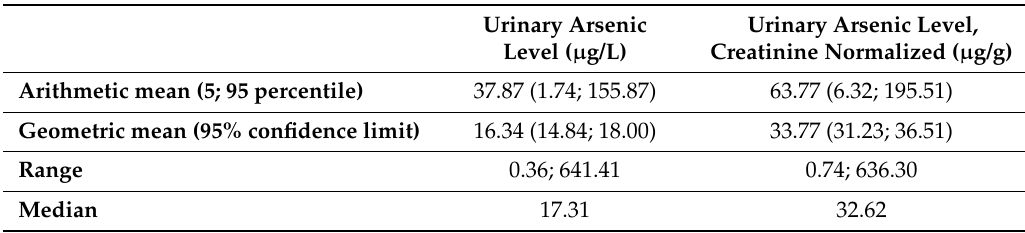
Table 2. Urinary arsenic concentrations in the study population ( N = 744), with and without creatinine